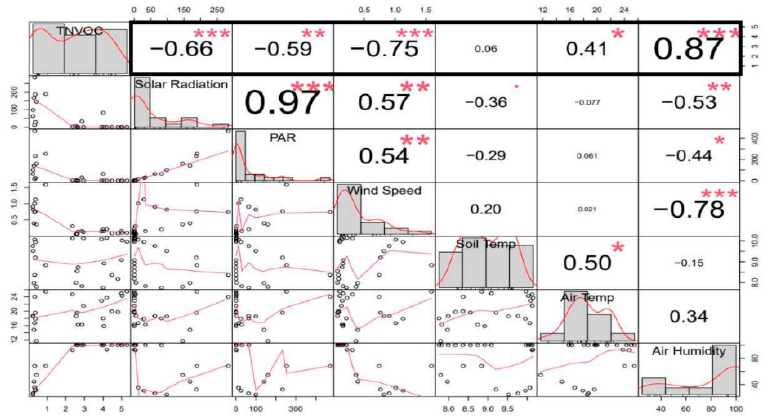
Figure 5. Pearson correlations between TNVOC and microclimate factors. * p < 0.05, ** p < 0.01 , *** p < 0.001.